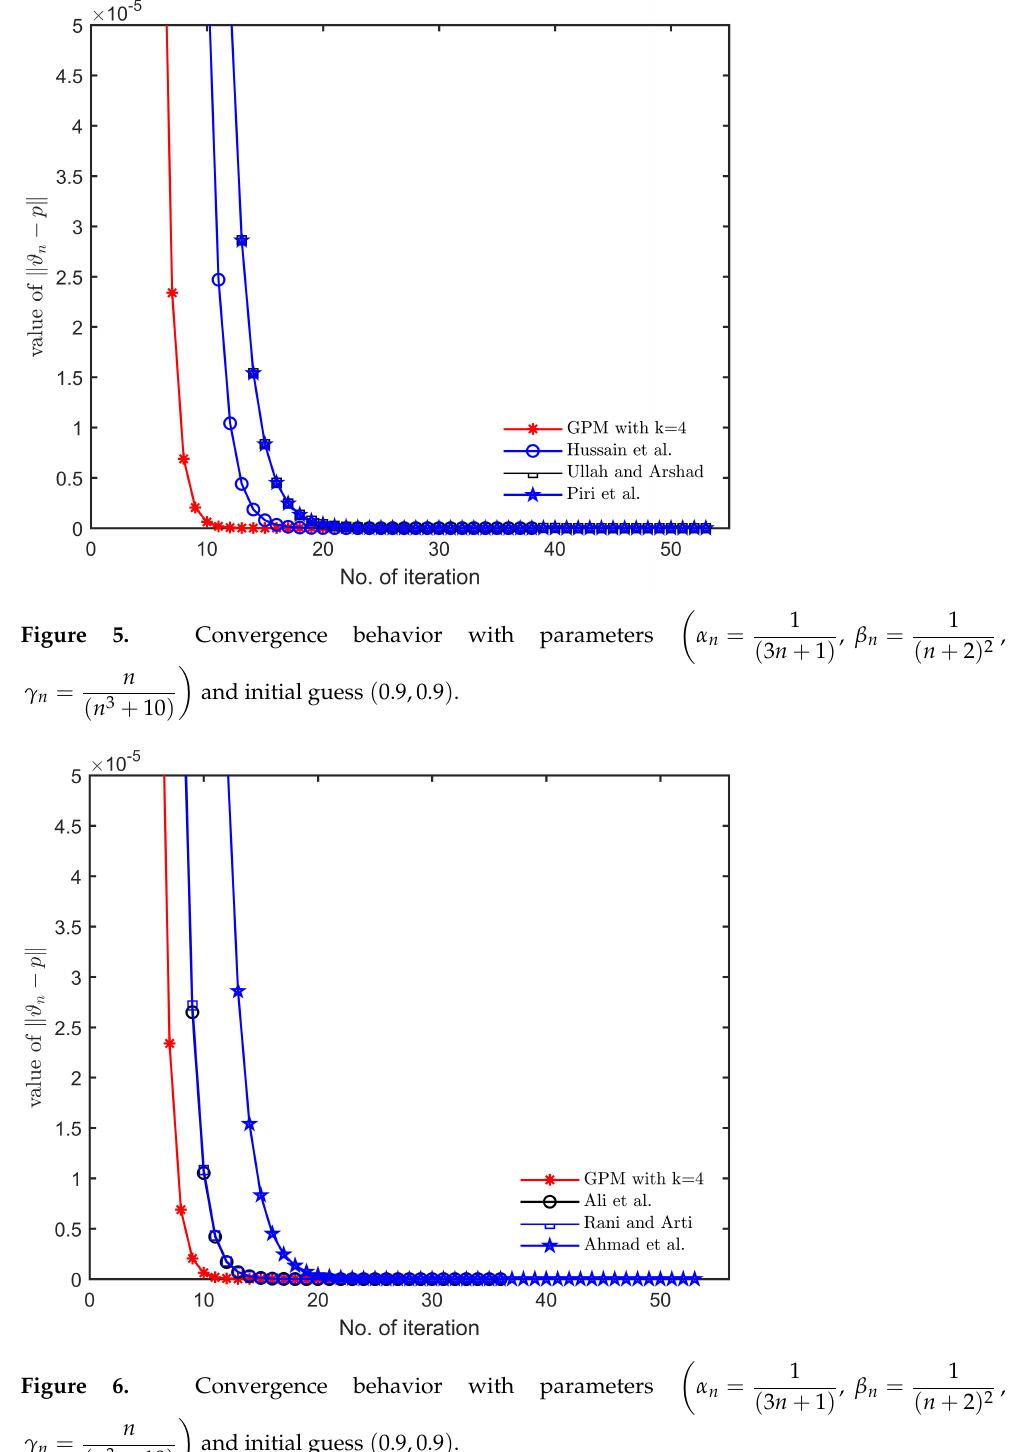
Figure 6. Convergence behavior with parameters (cid:19) n γ n = and initial guess ( 0.9,0.9 ) ( n 3 + 10 )